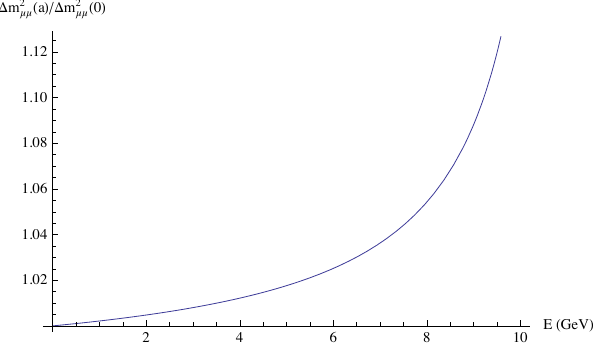
Figure 3 . The ratio (cid:1) m 2 ( a ) = (cid:1) m 2 (0) is plotted as a function of E in units of GeV. We take (cid:22)(cid:22) (cid:22)(cid:22) L = 1000 km. The mixing parameters and the matter density used are the same as in (cid:12)gure